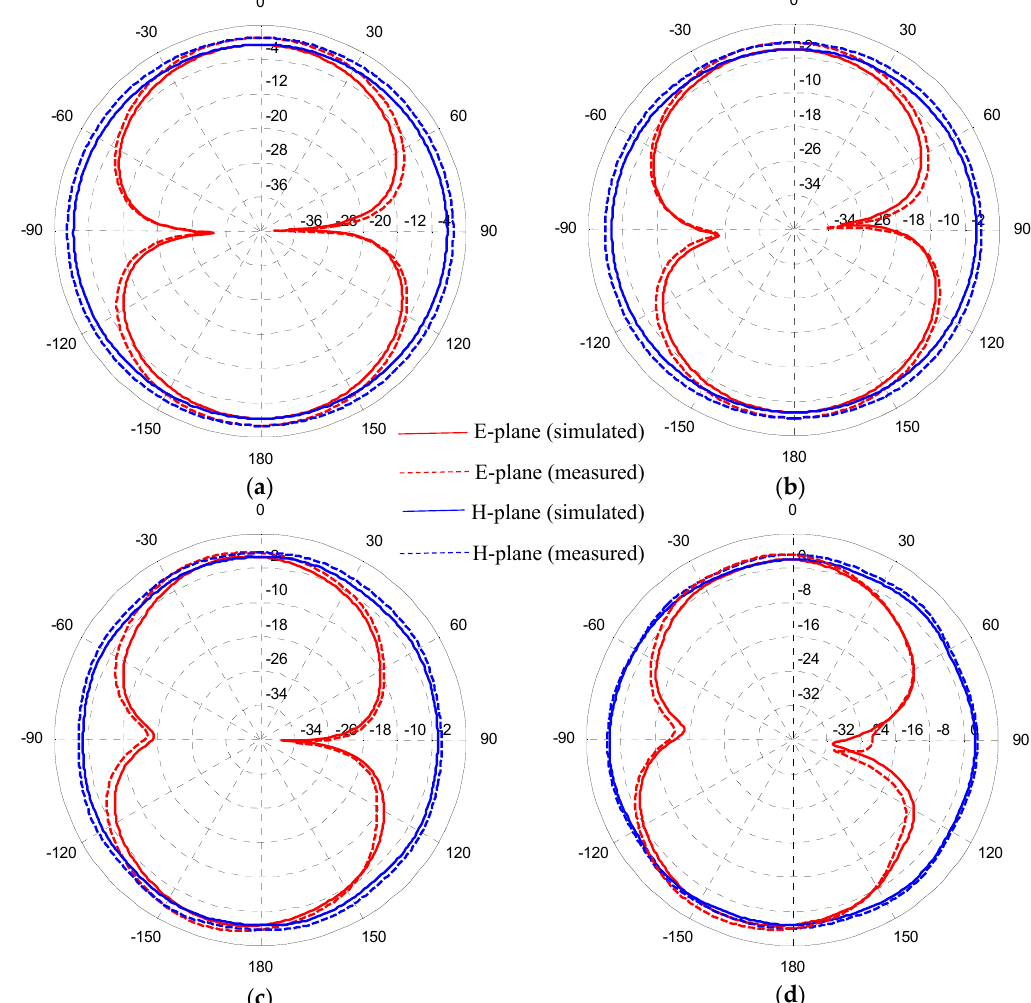
Figure 12. Simulated and measured radiation patterns for the proposed triple band-notched UWB antenna at ( a ) 3 GHz; ( b ) 4.5 GHz; ( c ) 8 GHz; ( d ) 12 GHz.